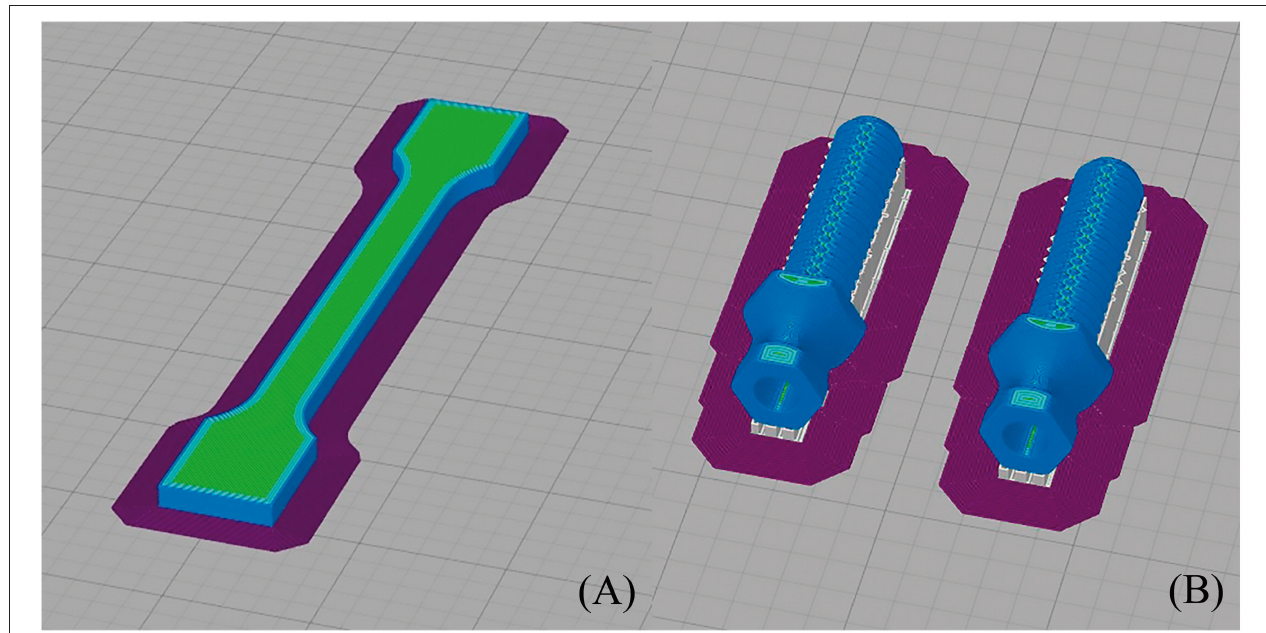
FIGURE 2 | Printing simulation of (A) dog bone sample (its dimensions were 75 ± 0.5mm length, 5 ± 0.2mm width, and 3.5 ± 0.2mm thickness, with a gauge length of 25 ± 0.5mm) and (B) endoprosthesis (its dimensions were 16.54*50.21*14.72 mm 3 , which are width, length, and thickness of the printing bed, respectively) in Simplify 3D.